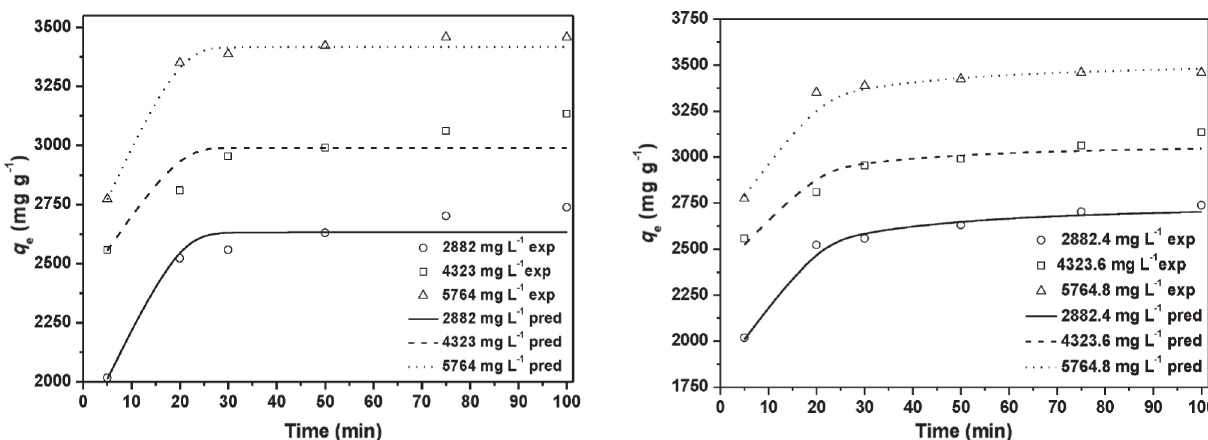
Fig. 9 – Pseudo-first-order kinetic fit for adsorption of acryl- ic acid onto CaO nanoparticles (initial acrylic acid concentra- 2 tion = 2882, 4323, 5764 mg L –1 , adsorbent dosage = 1 g L –1 , time = 125 min, and temperature = 300.15 K)